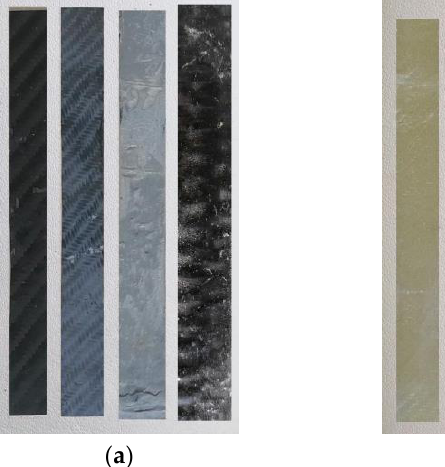
Figure 10. Composite material specimens for the shear and bending strength measurements: ( a ) carbon fiber-reinforced; ( b ) glass fiber-reinforced; ( c ) Kevlar-reinforced.